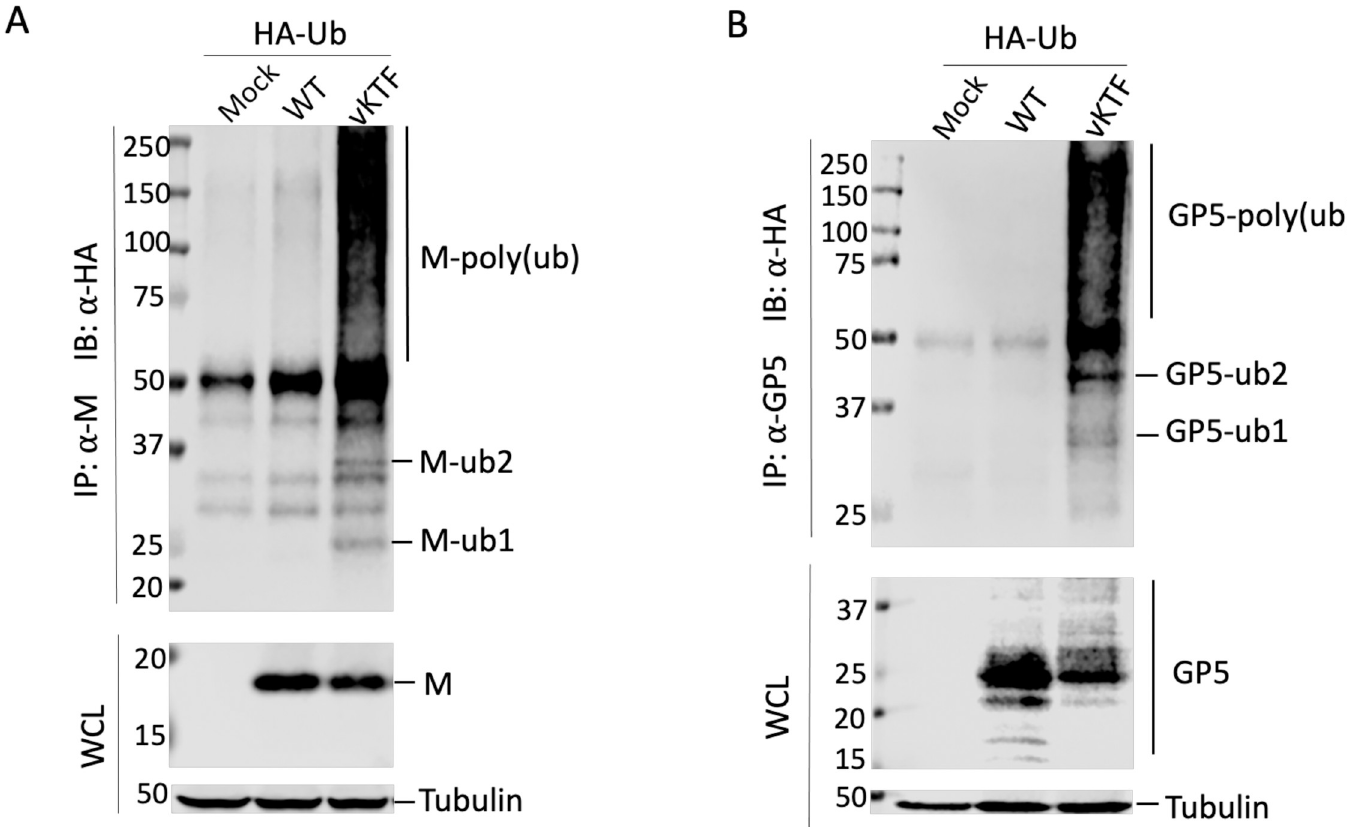
Fig 7. Nsp2TF deubiquitinating GP5 and M protein in the context of PRRSV-infected cells. ( A-B ) HEK-293T cells were co-transfected with a plasmid expressing HA-Ub and a PRRSV full-length infectious cDNA clone of WT virus or its mutant vKTF. The cell lysates were collected at 48 h post-transfection. IP was performed with anti-M pAb ( A ) or anti-GP5 pAb ( B ). Immunoprecipitated proteins were separated by SDS-PAGE and analyzed by Western blot using anti-HA mAb ( A-B ). Western blot analysis was also conducted with pre-IP whole cell lysates using M-specific mAb ( A ) or GP5 specific mAb ( B ). Tubulin was detected as a loading control. IP: immunoprecipitation; IB: immunoblotting; WCL: whole cell lysates.